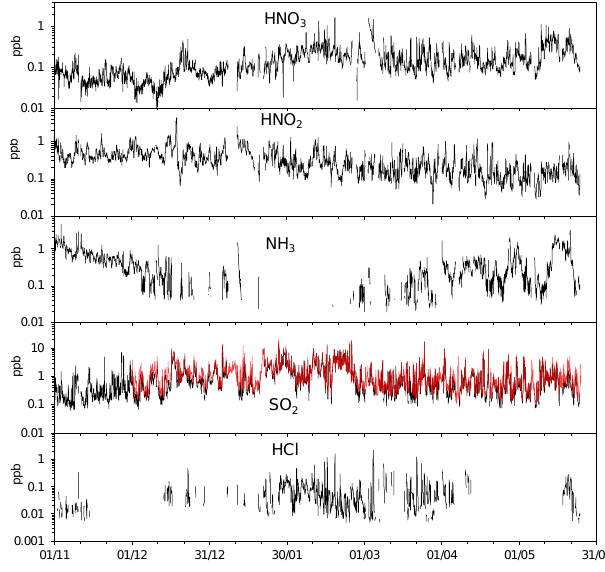
Fig. 5. Hourly-averaged concentrations of gases measured with the MARGA (HNO 3 , HNO 2 , NH 3 , and SO 2 ) at SMEAR III from 1 November 2009 to 25 May 2010. The red line in the SO 2 time series is the data measured with a TEI 43iTL